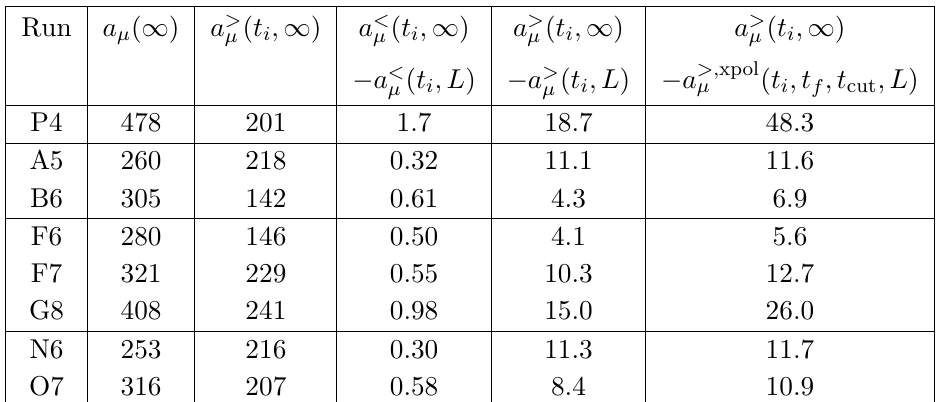
Table 10 . Estimates of the (cid:12)nite-size e(cid:11)ects on a hvp non-interacting pions for the ‘short-distance’ contribution a < of the timelike pion form factor and the L(cid:127)uscher formalism for the ‘long-distance’ contribution a > The last column is discussed in section C.3. We used the values t i = ( m (cid:25) L= 4) 2 =m (cid:25) , t f = 1 fm and t cut = max( t i ; 1 : 35 fm). The parameters used for the di(cid:11)erent ensembles are listed in table